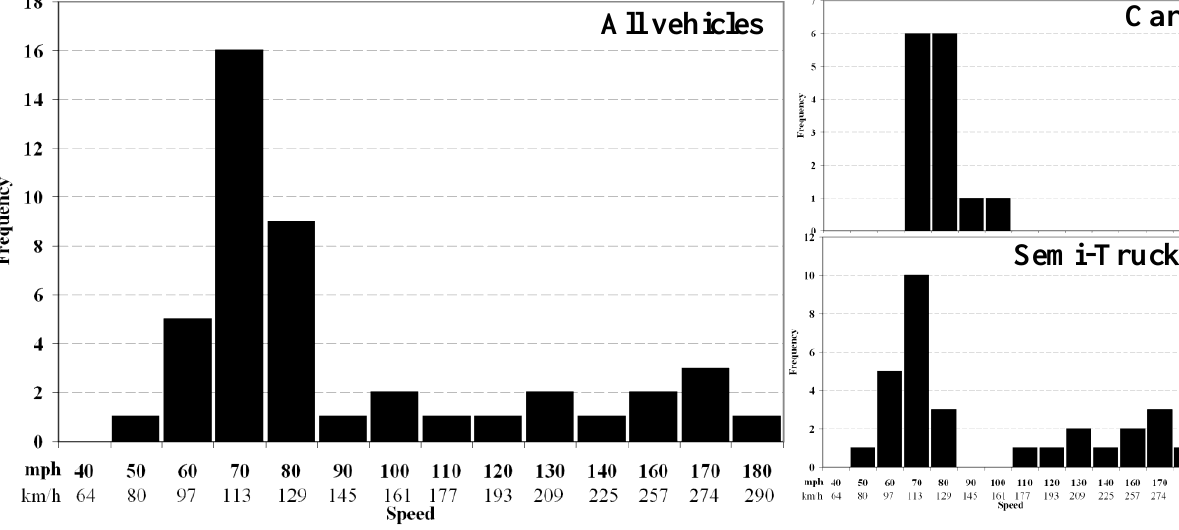
Figure 5. Distribution of speed frequency for vehicles on highway segment. All